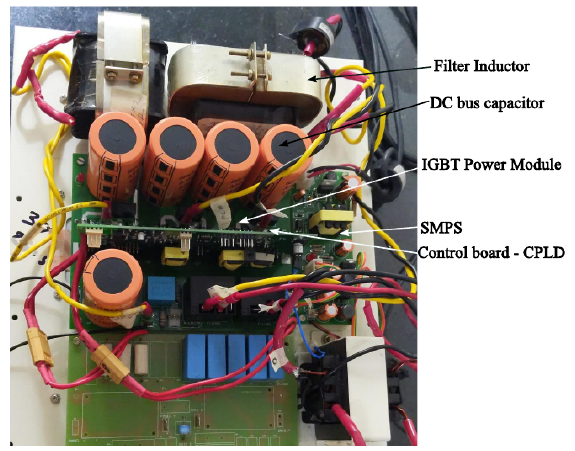
Figure 21. Experimental set up: 2 kW GI-VSI prototype.